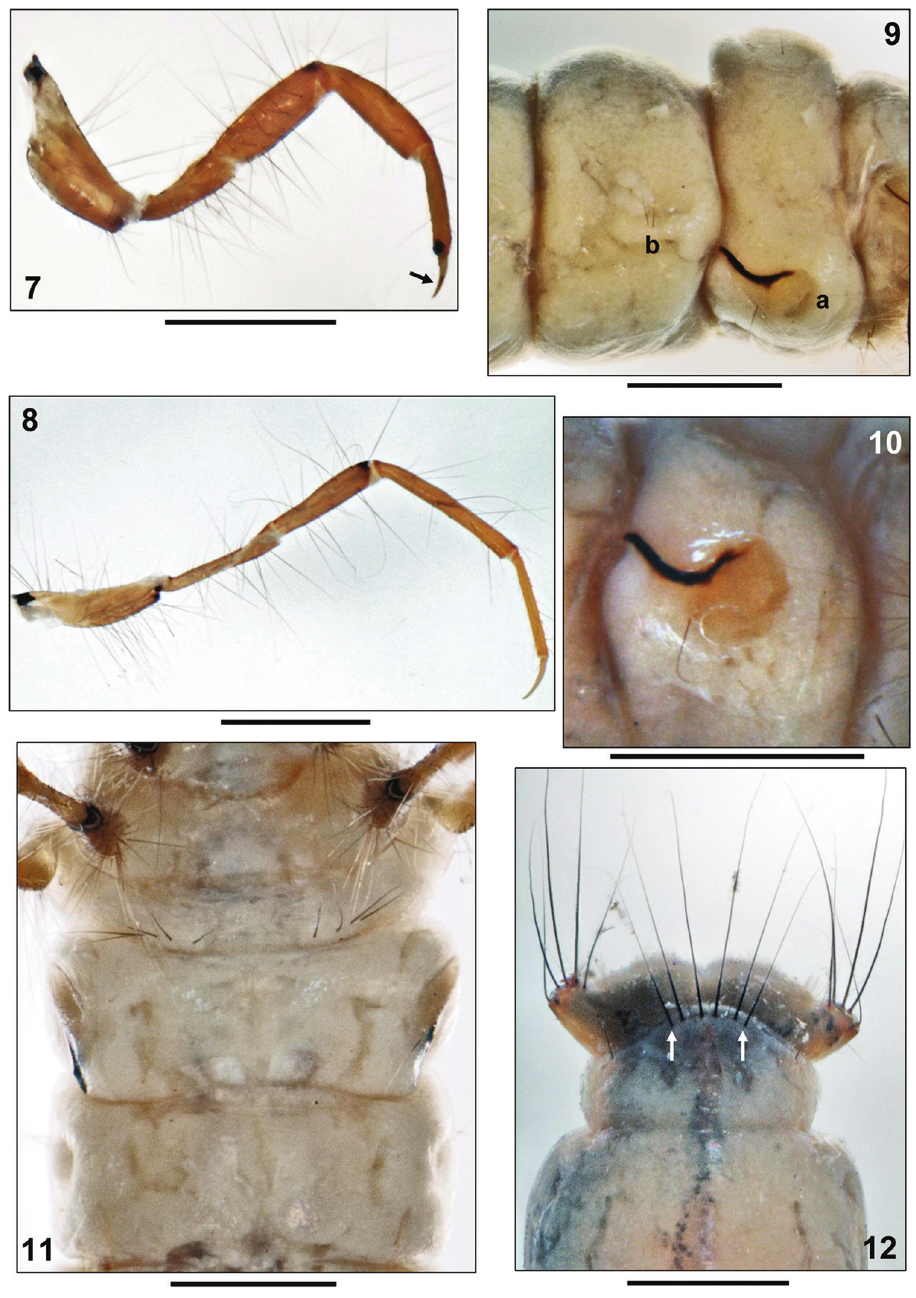
Figures 7–12. Adicella syriaca Ulmer 1907, final instar larva. 7 Right midleg, posterior face (arrow: tarsal claw not hook-shaped) 8 Right hind leg, posterior face 9 Abdominal segments I and II, right lateral (a= lateral sclerite; b= lateral setae) 10 Lateral sclerite, detail 11 Sterna of metathorax and abdominal segments I and II 12 Tip of abdomen, dorsal (arrows= outermost setae of ninth abdominal tergite). Scale bars: 0.5